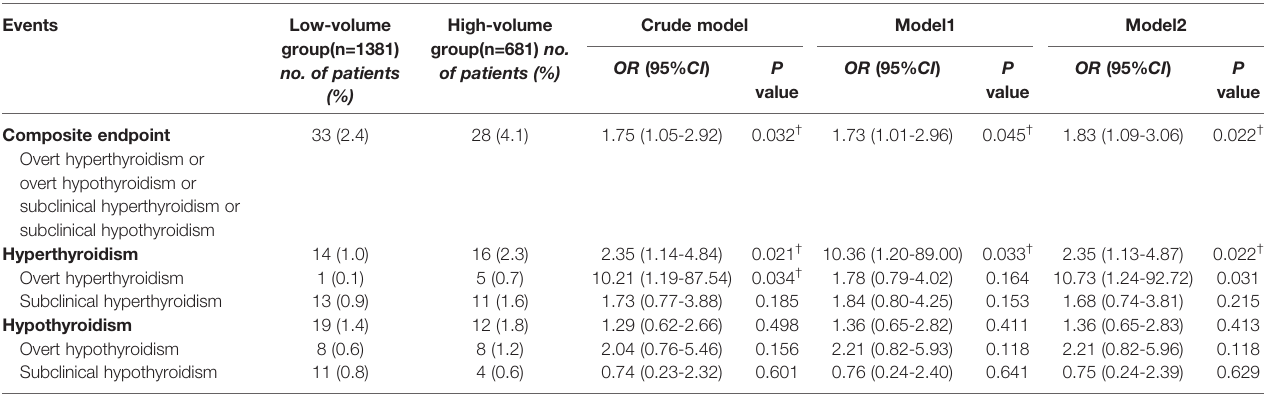
Binary logistic regression analysis with enter method was performed to determine the association between noncomplex PCI group and complex PCI group for thyroid disease. Crude model: Unadjusted model. Model 1, adjusted for age, gender and obesity. Model 2, adjusted for age, gender, obesity, current smoker, hypertension, hyperlipemia and previous stroke. † P < 0.05. OR, odds ratio; CI, con fi dence